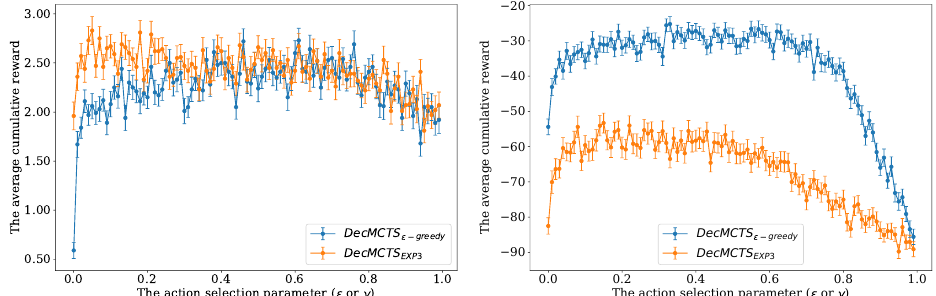
Figure 9. The average cumulative reward over the action selection policy parameters: (cid:101) and γ in MMDP Problems. ( left ) The fire fighting problem. ( right ) The meeting in grid problem. The whiskers show the standard error.